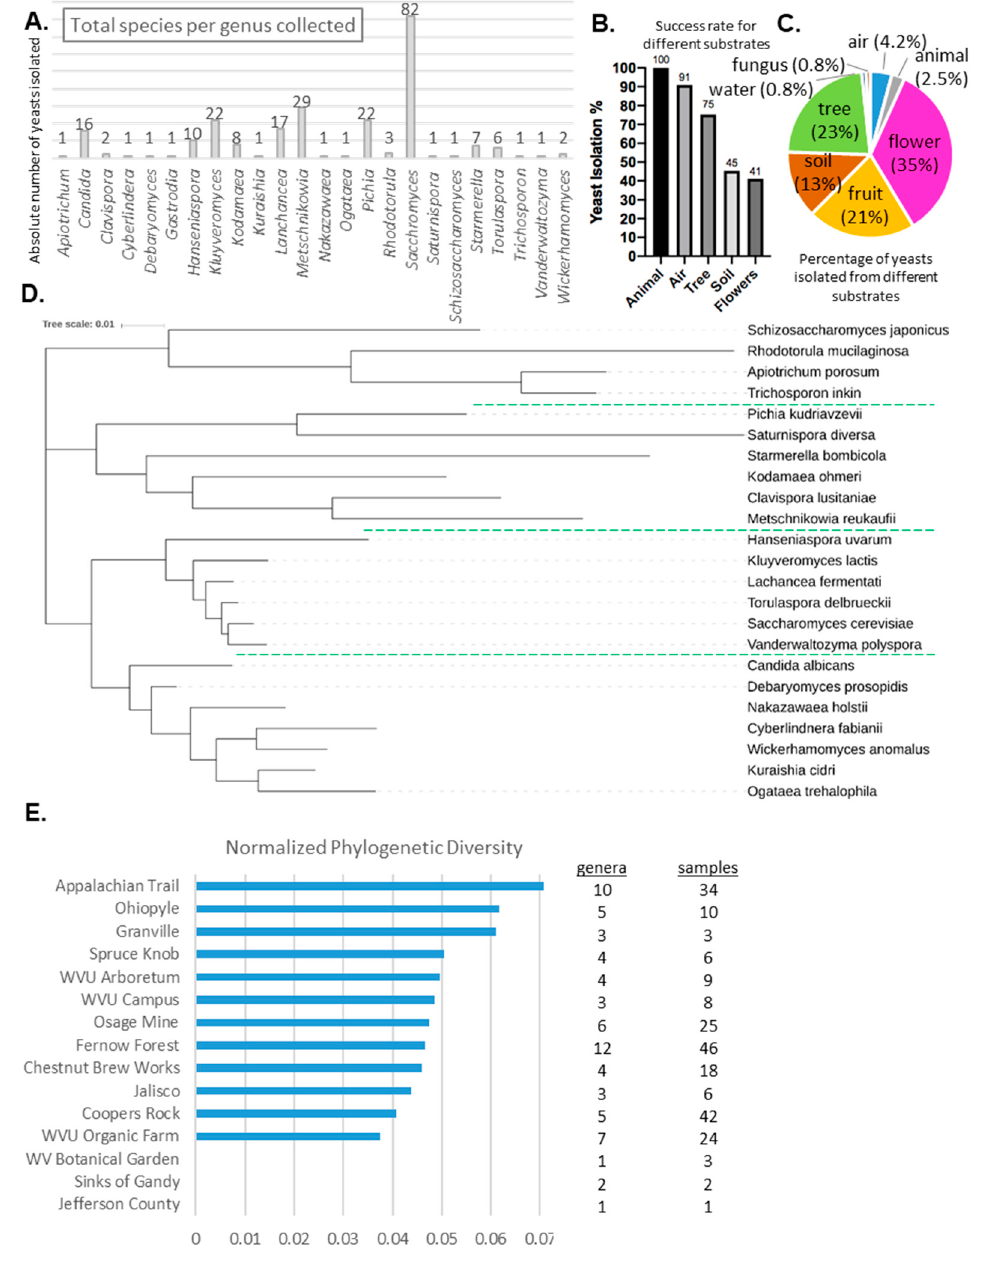
Figure 3. Phylogenetic diversity of yeast isolated from environmental samples. ( A ) The number species identified from each genus were graphed. ( B ) Success rate of isolating di ff erent species from di ff erent substrates. ( C ) Comparison of di ff erent types of substrates that that contained isolated yeast species. ( D ) Phylogenetic tree of genera identified. One representative species from each genus was used. ( E ) Phylogenetic diversity of each location normalized by the number of individual species identified. The number of genera identified and the number of unique yeast species from the samples are noted.